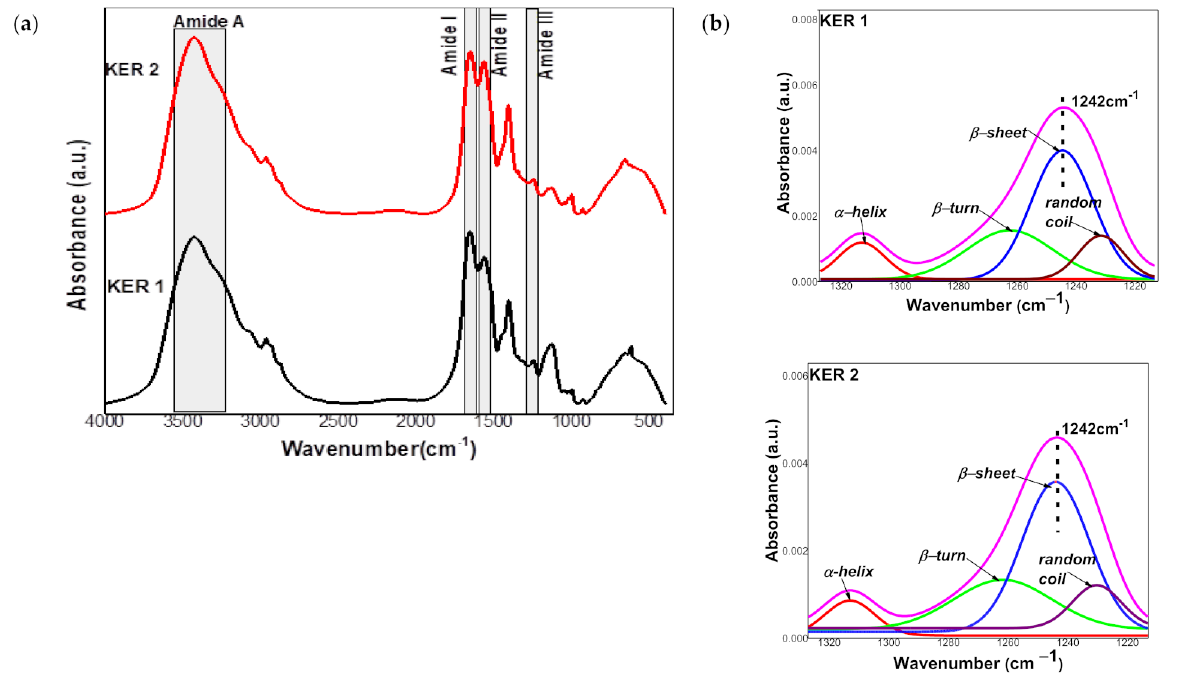
Figure 4. ( a ) FTIR spectra of Ker1 and Ker2; ( b ) Amide III band deconvolution of Ker1 and Ker 2.